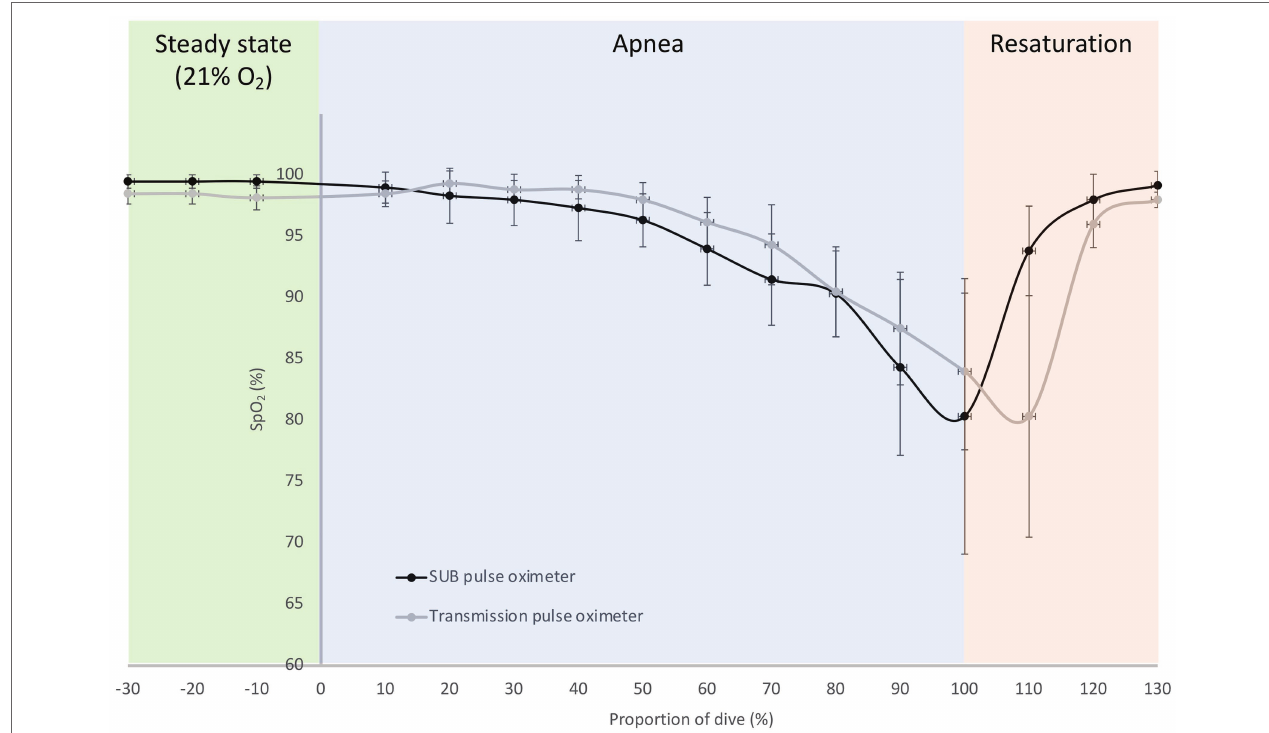
FIGURE 7 | Mean (SD) relative oxygen saturation (SpO 2 ) traces during a maximal breath-hold for the SUB pulse oximeter and the Lifesense transmission pulse oximeter; dive time is expressed as a percentage of the total dive duration (184 ± 53 s) for six